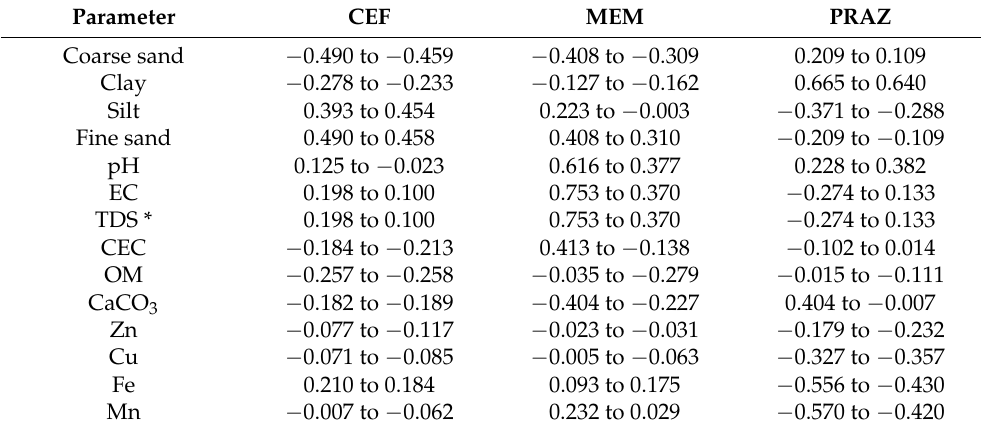
Table 4. Change in Pearson’s correlation coefficients between soil/sediment physicochemical proper- ties and K d value of studied pharmaceuticals with change in OM concentration (from 0 to 100 mg/L humic